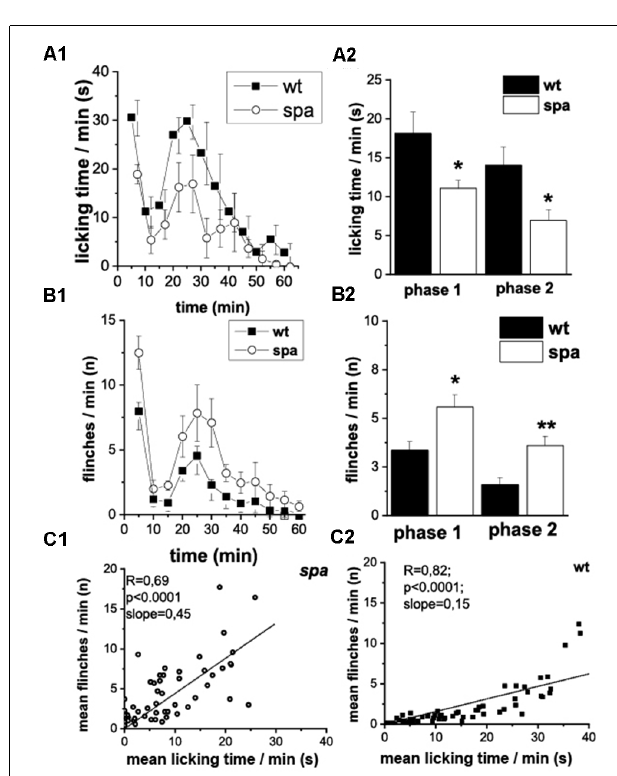
FIGURE 4 | Formalin test; PRB after formalin injection. (A) Time course of licking activity (left panel; A1 ) and mean licking time in phase 1 (0–10 min) and 2 (right panel; A2 ). The licking time was reduced in spastic animals during the 60 min of the test. (B) Time course of flinches (B1) and mean flinching in phase 1 and 2 (B2) . The number of flinches per minute was increased in mutant mice in both phases. Phases of both acute (0–15 min, phase 1) and delayed (>15 min phase 2) PRB could be clearly distinguished by measuring either flinching or licking-time. (C) Mean flinching frequency over the mean licking time frequency at individual minutes comparing spastic (C1) and wildtype (C2) mice. The number of flinches per minute was correlated positively with the mean licking time (* p < 0.05; ** p < 0.01).